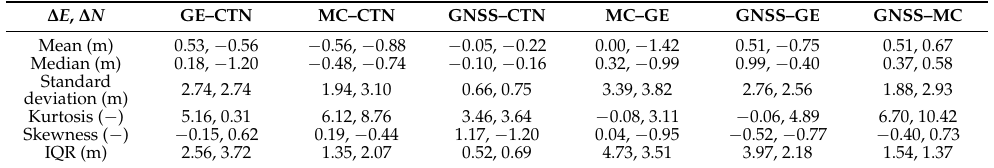
Table 2. Descriptive statistics of ∆ h : mean, median, standard deviation, kurtosis, skewness, and IQR. ∆